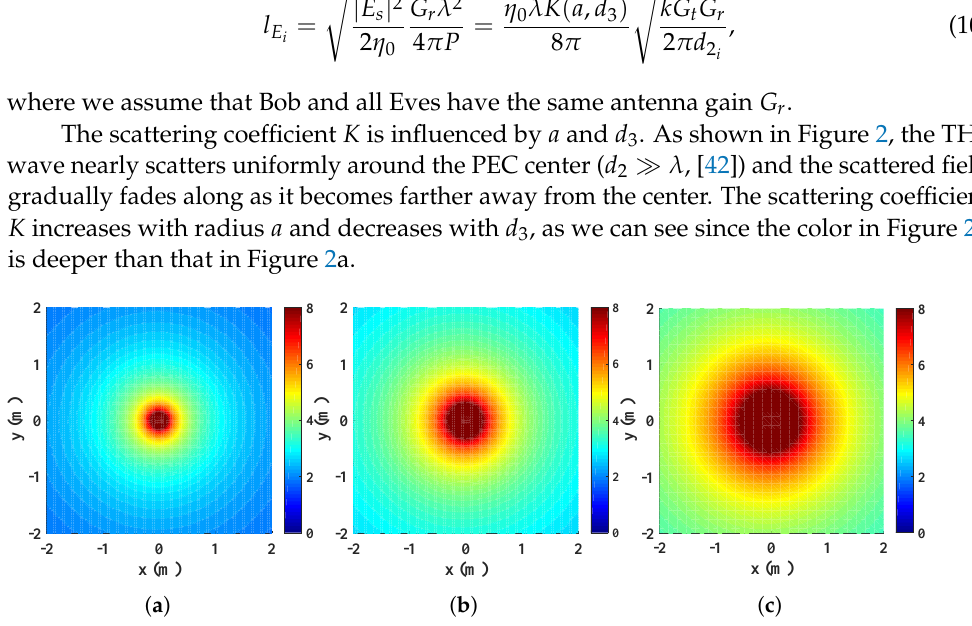
Figure 2. The scattered fields of PEC for ( a ) a = 20 mm, d 3 = 2 m ( b ) a = 40 mm, d 3 = 2 m ( c ) a = 40 mm, d 3 = 1.5 m. The maximum values were cut off at 8 since only a few values exceed it. Unlike the main channel wherein a direct line-of-sight (LOS) link exists between Alice and Bob, Eve indirectly receives the signal information from non-line-of-sight